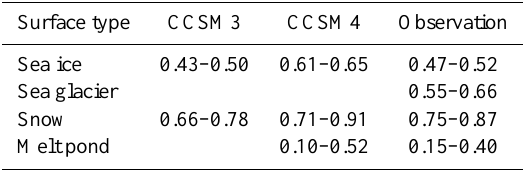
Table 1. Typical albedos for sea ice ( > 1m), sea glacier (compressed snow over ocean), snow and melt pond in CCSM3, CCSM4 (see Briegleb and Light, 2007; Yang et al., 2012a) and observations (see Perovich, 1996; Warren et al., 2002; Warren and Brandt, 2006). Surface